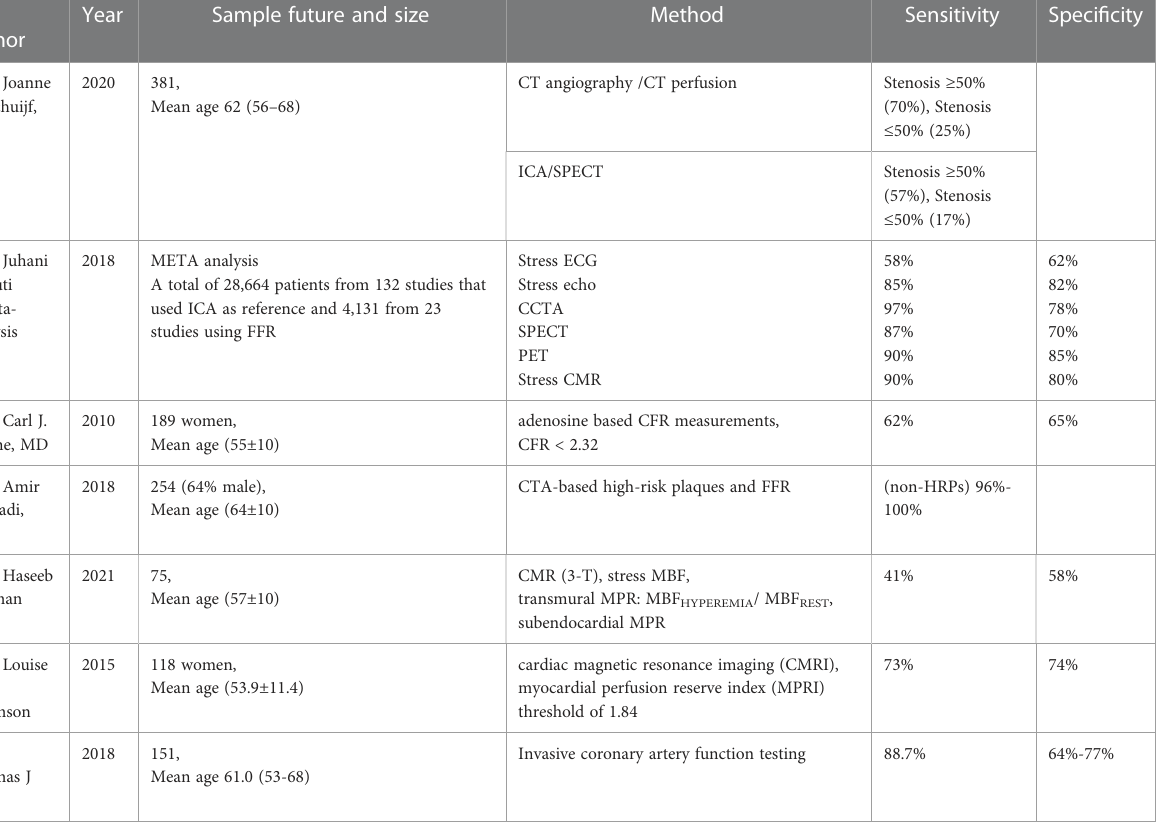
TABLE 1 Comparison of methods for detecting